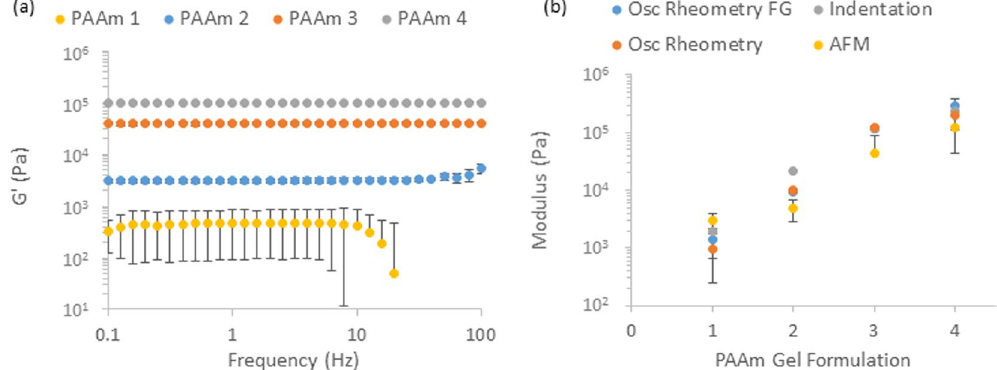
Figure 5. ( a ) Bulk mechanical characterisation of PAAm by oscillatory rheometry (frequency Sweeps) across a range of AAm and crosslinker concentrations (see Table 1 for details of compositions of PAAm1-4, as indicated in the legend), frequencies tested were from 0.1–100 Hz at an oscillating displacement of 10 − 4 rad on a minimum of three repeats and ( b ) comparison of the modulus of the softest PAAm sample measured moduli with and without functionalised geometry and between bulk (rheology and micro indentation) and local (nanoindentation by AFM) testing methods. Error bars showing the standard